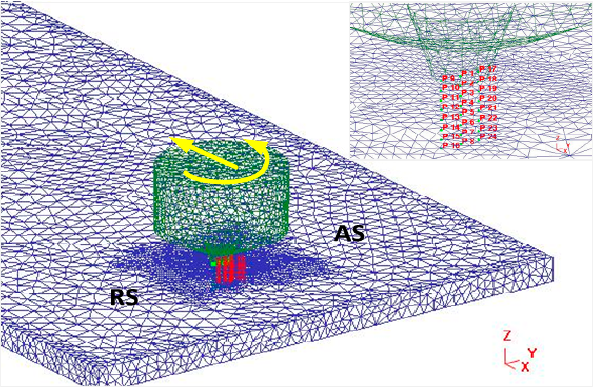
Figure 10. Setting of tracking particles inside the tool pin.